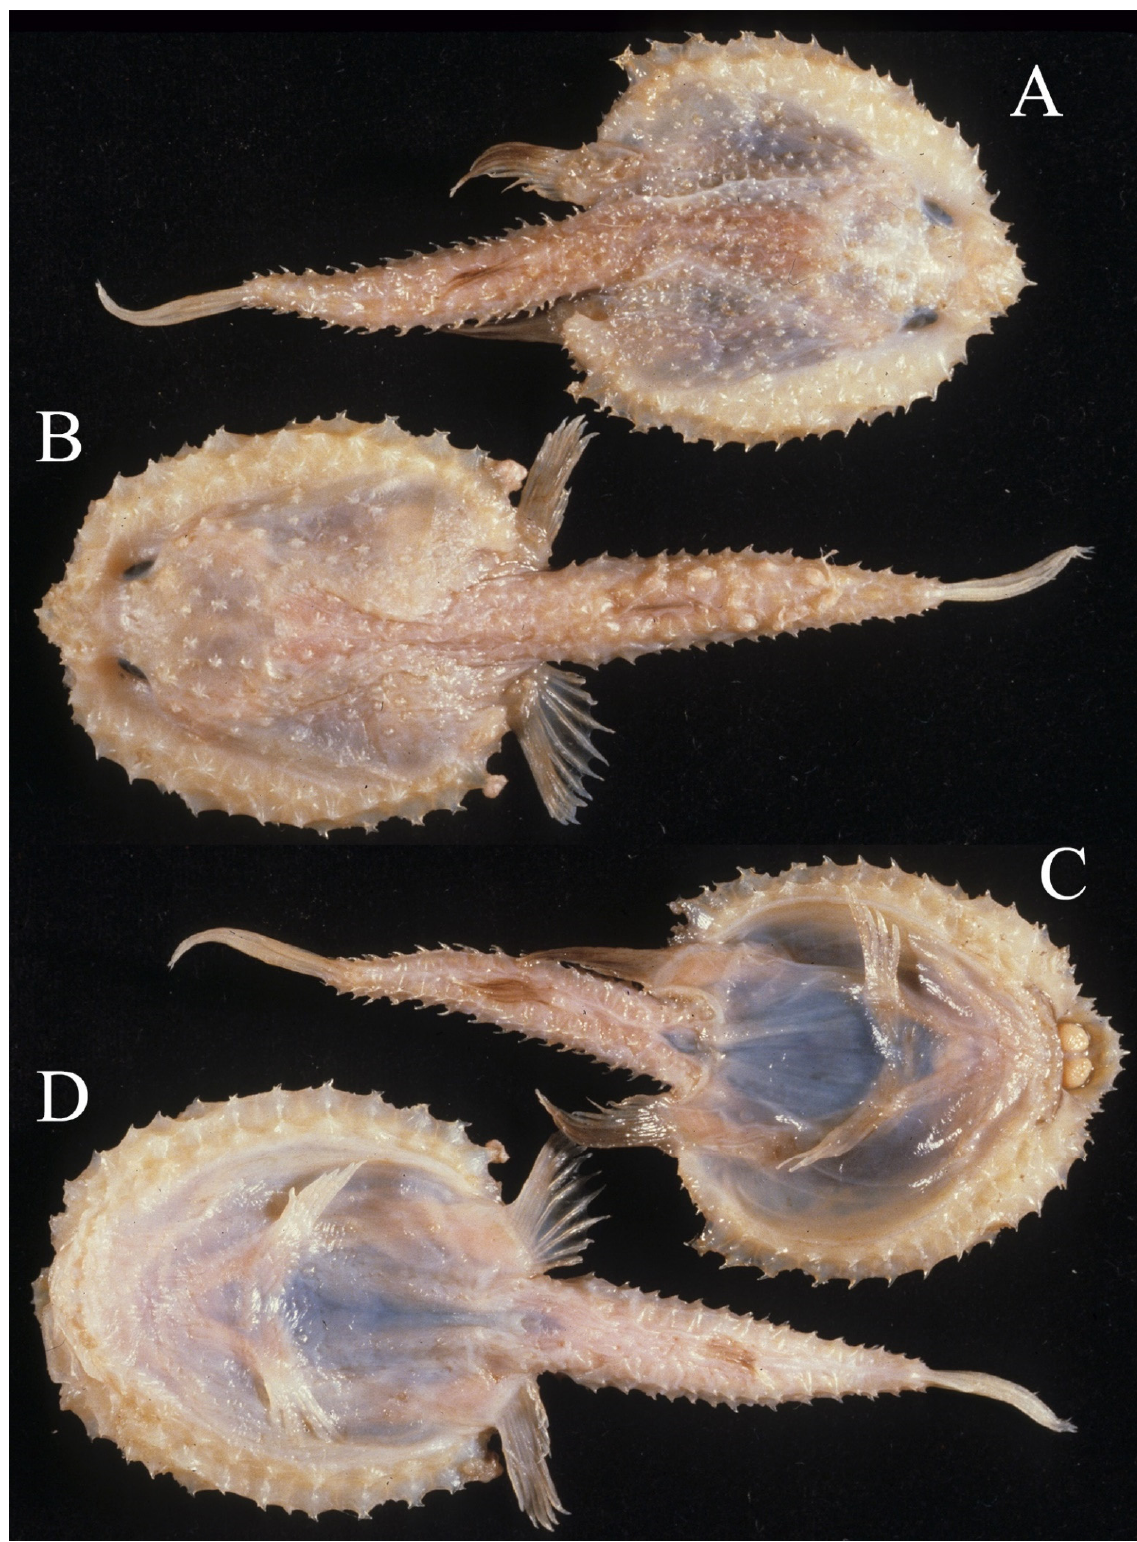
Figure 24. Comparison of dermal squamation and rostrum of H. bathyoreos Bradbury, 1988 ( A , C , 61.6 mm SL) and H. nudiventer (Lloyd, 1909) ( B , D , 69.8 mm SL), both in ZMMU P15810, 2 of 4, photos by M. G.